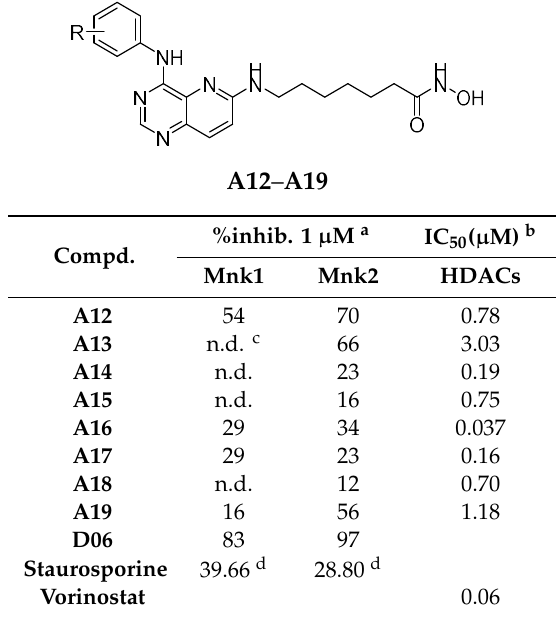
Table 2. In vitro enzyme inhibitory activity of target compounds A12 – A19 .